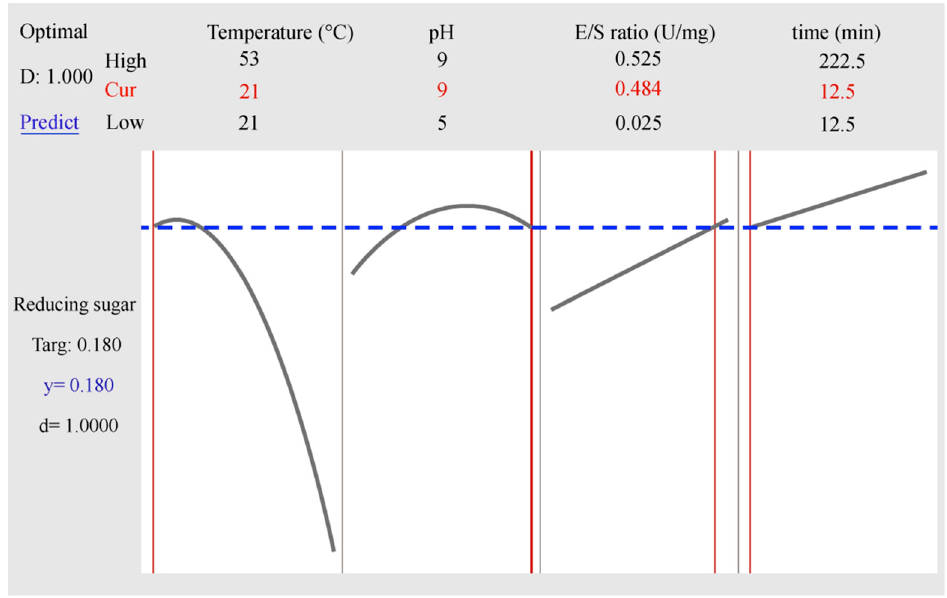
Figure4. OptimizationresultsbyMINITAB17forPGOswithDParound3, usingthe C.japonicus enzyme.